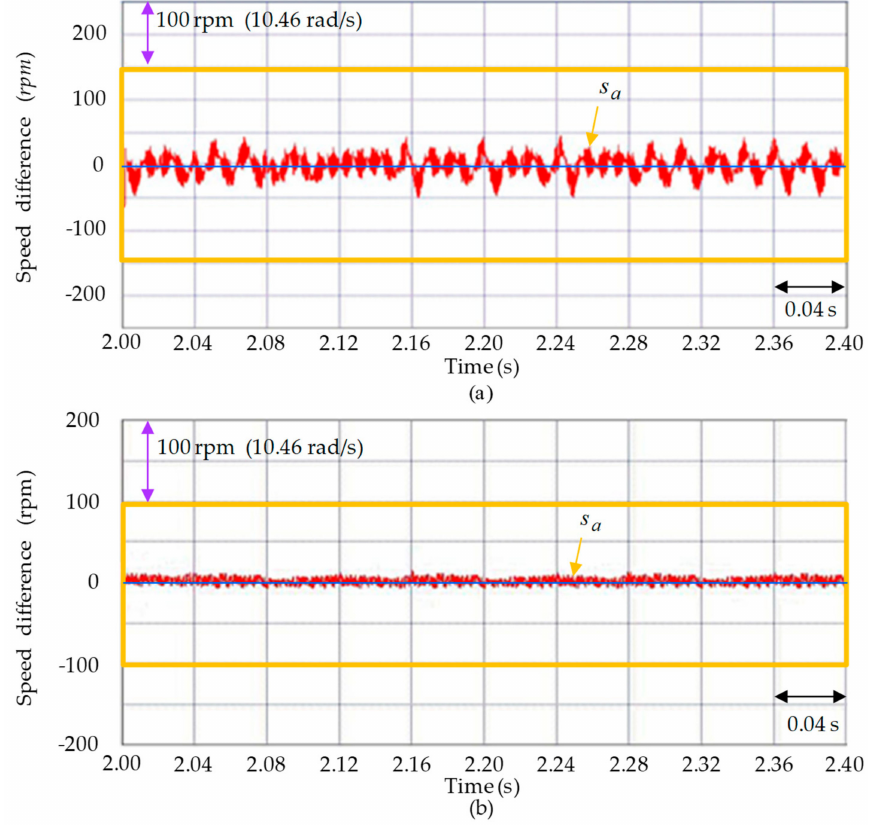
Figure 11. Increase in speed difference responses via experimental results for the ISM driving the rice milling machine system in test JB by adopting the controllers: ( a ) TA; ( b )